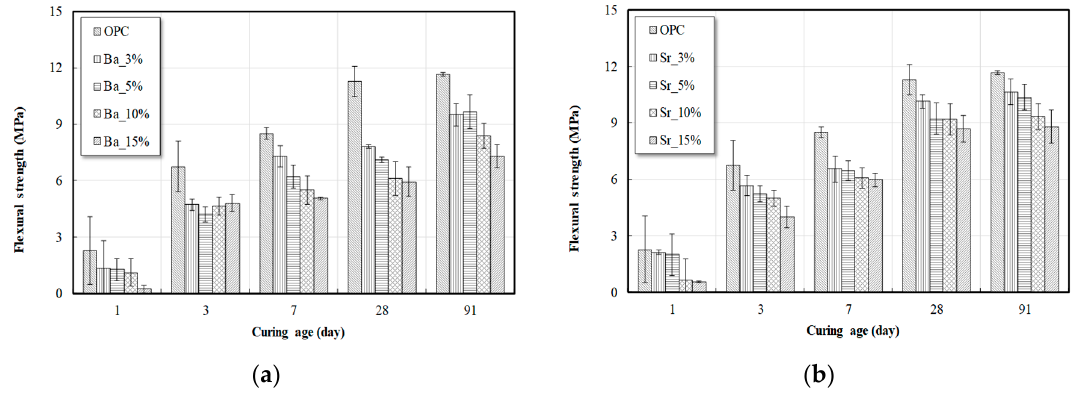
Figure 8. Effects of addition mix ratio of PCM on flexural strength—( a ) cement mortar with PCM-Ba; ( b ) cement mortar with PCM-Sr.